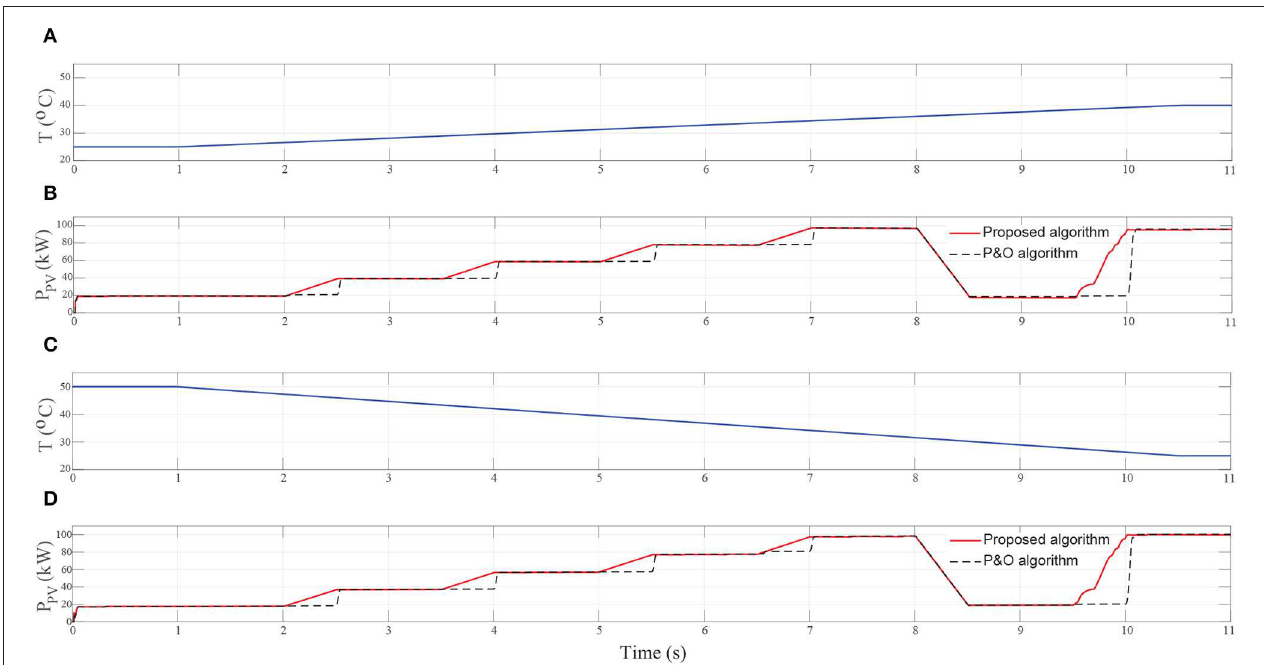
FIGURE 9 | Simulation results for rapid change of solar irradiation and slow change of temperature. (A) Temperature increases gradually. (B) The simulation result in case temperature increases. (C) Temperature decreases gradually. (D) The simulation result in case temperature decreases.